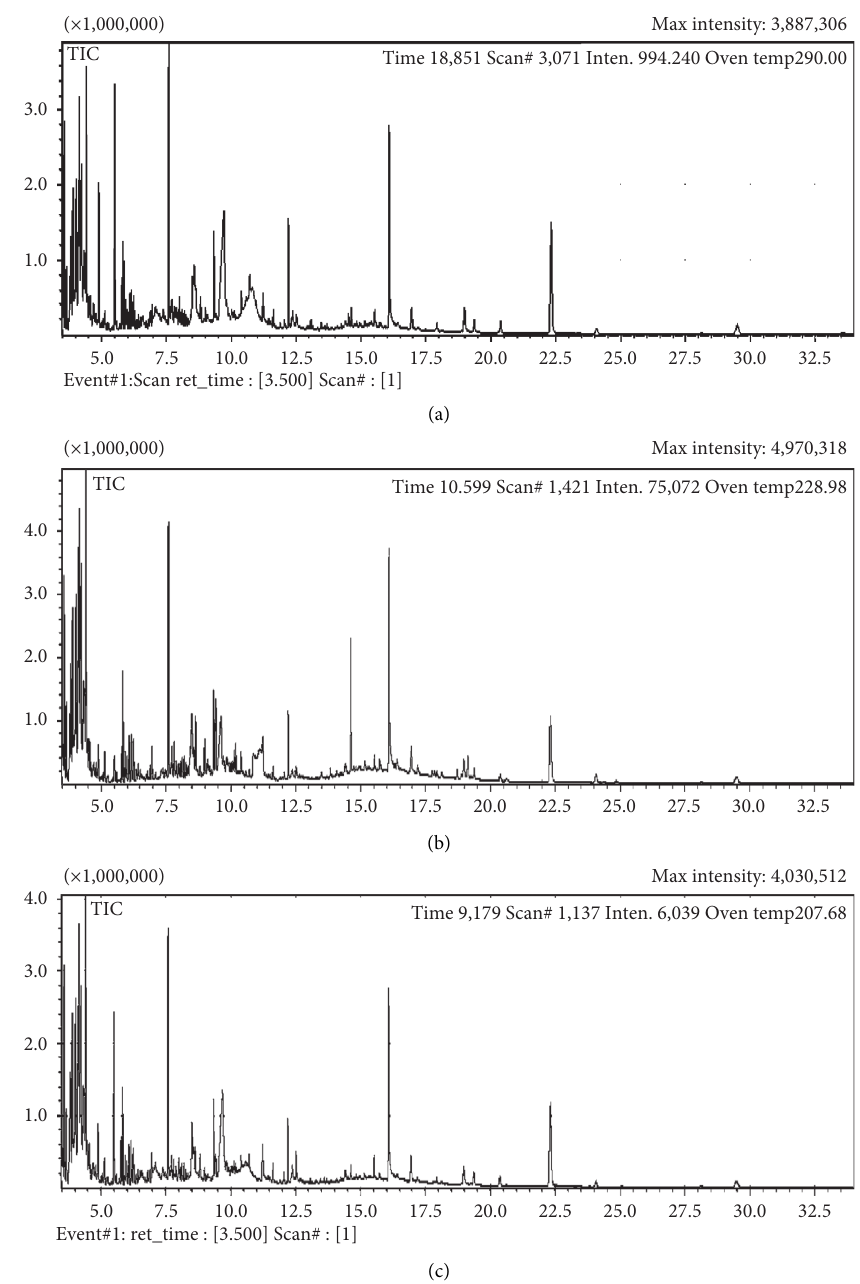
Figure 1: Representative typical GC-MS total ion current (TIC) chromatograms of three ethanolic extracts of khat samples: (a) young Kofat N1 , (b) mature Kofat G1 , and (c) young Gahasha N3